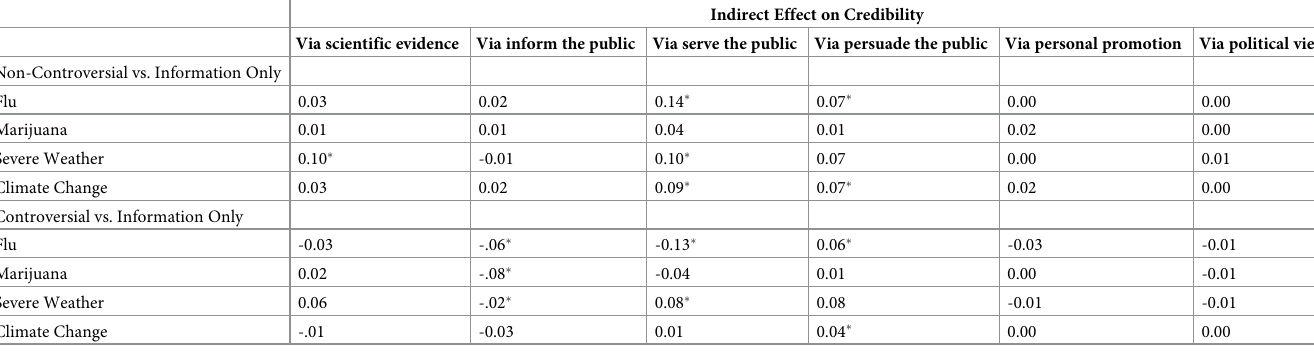
Table 5. Indirect effects of solution position on credibility, through perceived scientist